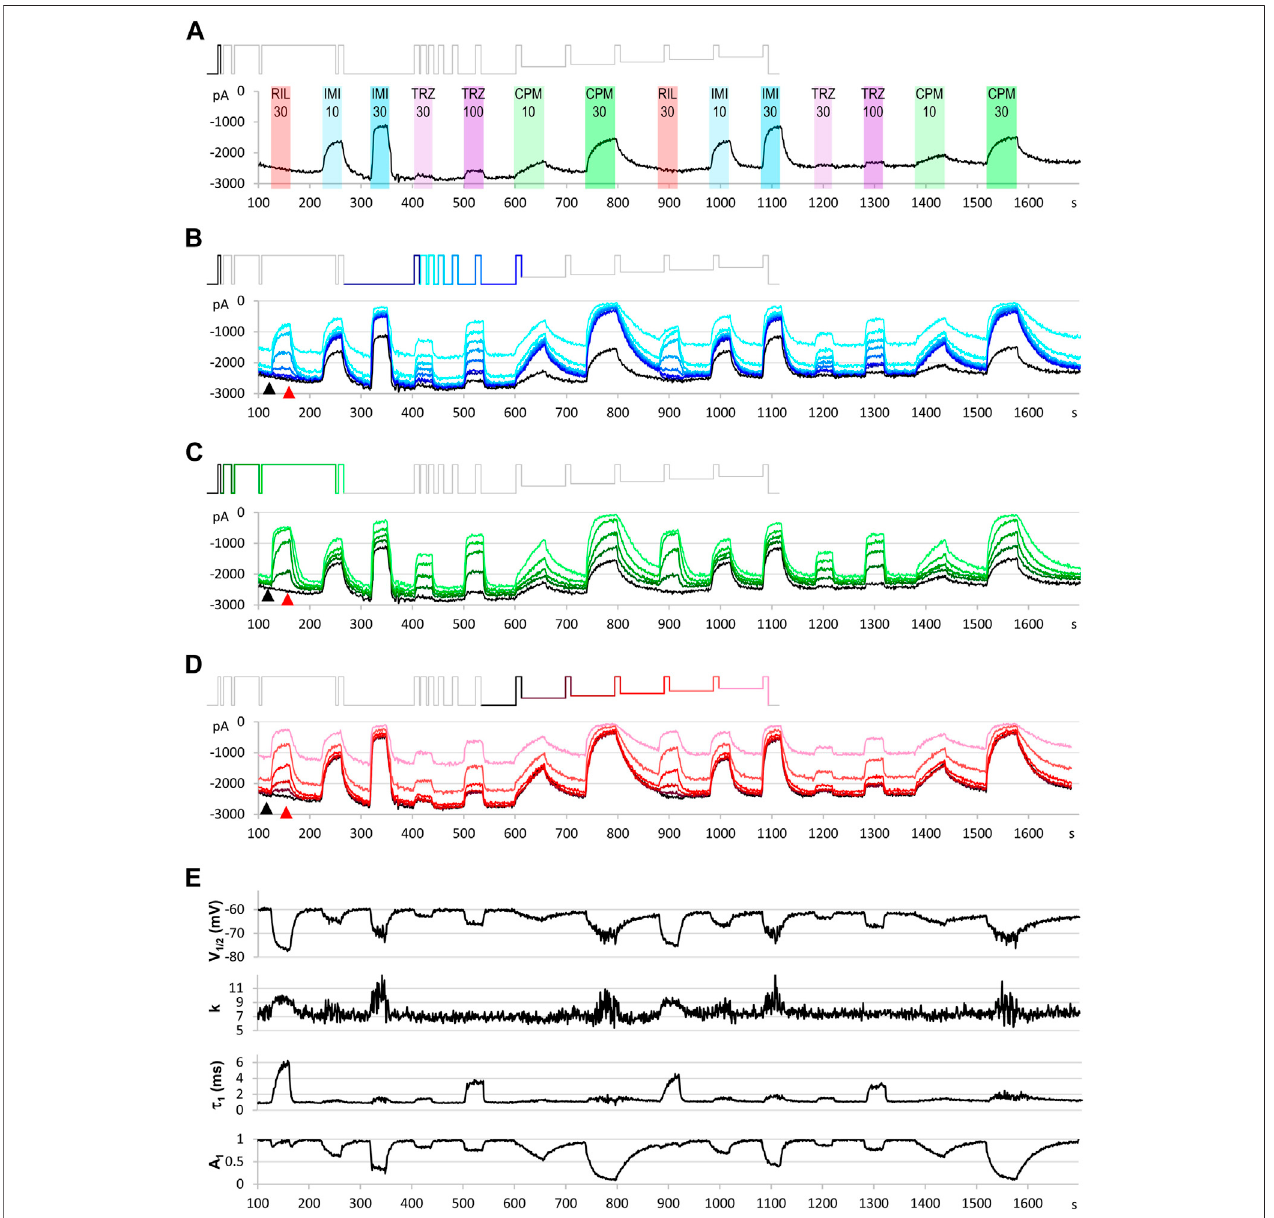
FIGURE 3 | An example for the plot of current amplitudes throughout the experiment. The experiment included two repetitions of seven different compound applications: 30 µM riluzole, 10and 30 µM imipramine, 30and 100 µM trazodone, 10and 30 µM chlorpromazine.Currents evokedbyall 17depolarizations are shown, grouped into three functional assays, as described in the text. (A) Peak amplitude plot for pulse #1-evoked current throughout the experiment. (B) Currents evoked by pulses #1 and #6 – #12; these allow second-to-second reconstruction of recovery from inactivation (RFI; see Materials and Methods ) throughout the experiment. (C) Currents evoked by pulses #1 – #5; these allow reconstruction ofthe SDO plots (see Materials and Methods ). (D) Currents evoked bypulses #1 and #13 – #17; these allow reconstruction of the SSI plots (see Materials and Methods ). Insets show the schematic picture of the voltage protocol, where colors match the color of the corresponding amplitude plot. (E) Results of the automated analysis. Automated fi tting of SSI and RFI data was done as described in Materials and Methods . The plot shows the changes in half inactivated voltage ( V 1/2 ) and slope ( k ) values from SSI data, and the value ( τ 1 ) and contribution ( A 1 ) of the fast time constant from RFI data.